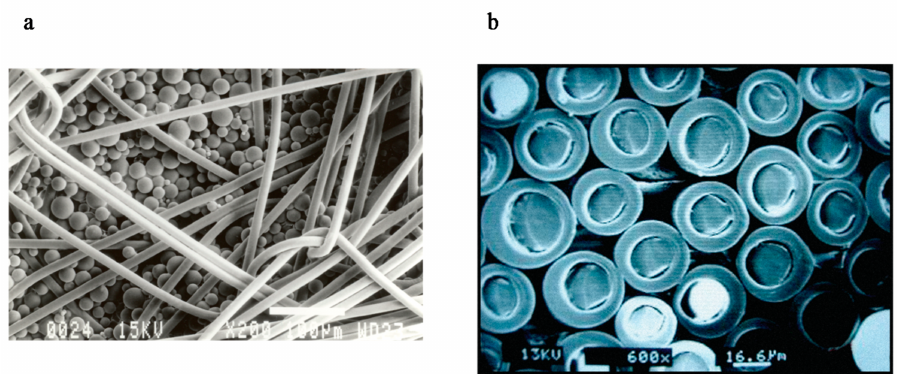
Figure 2. Phase change microcapsule applied onto textile as a coating ( a ), magnification 200 × . Phase change material incorporated into the core of a fibre ( b ), magnification 600 × . Source: Outlast